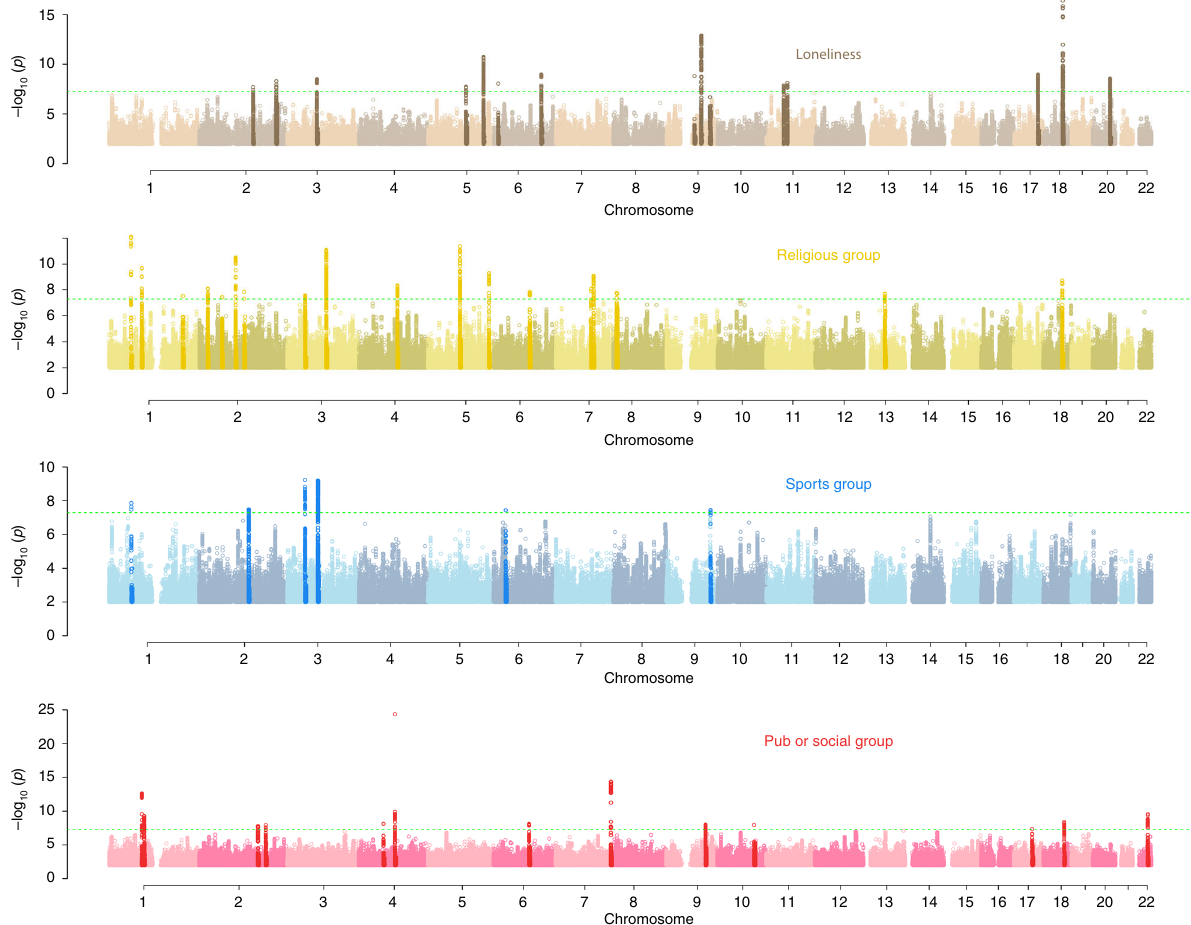
Fig. 1 Manhattan plots for the four social interaction traits. In each case the green horizontal dotted line denotes genome-wide signi fi cance, and the highlighted SNPs are in loci within 300 kb of the identi fi ed signals. In the case of loneliness (top panel) the results are from multi-trait GWAS, in the other cases the results are from linear mixed